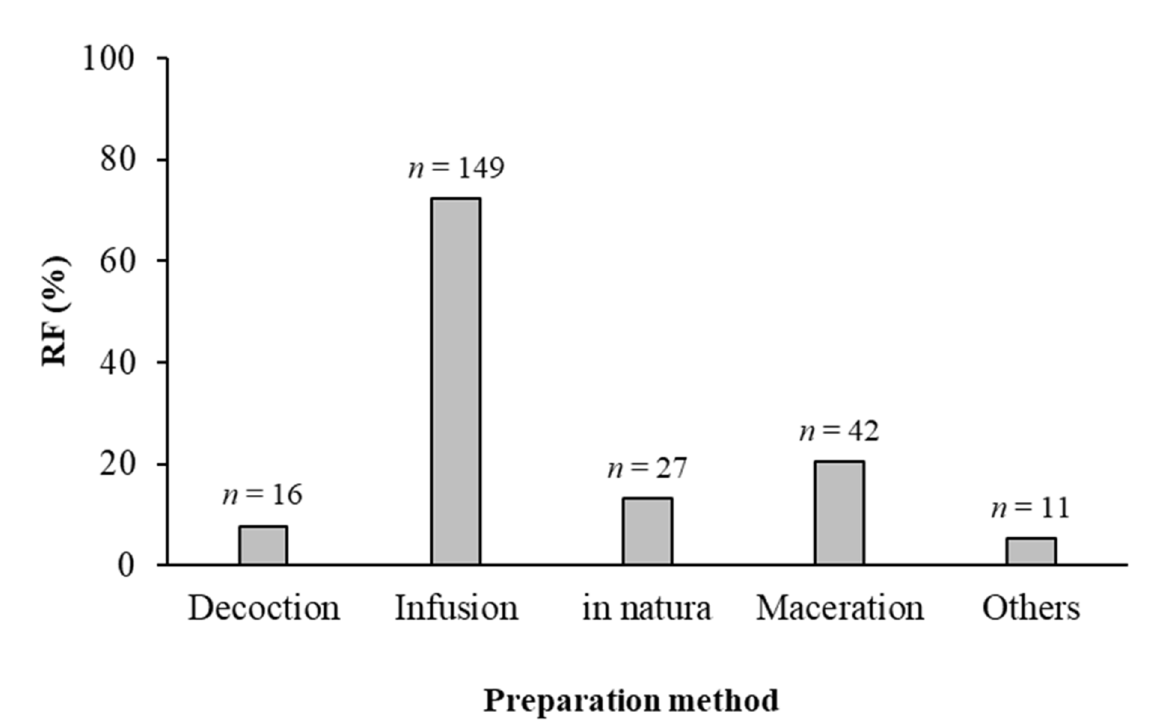
FIGURE 2 – Main methods of herbal preparations cited by the students and their associated community at a public school in Vila Velha (Brazil). n represents the number of answers for each category considering 206 people.